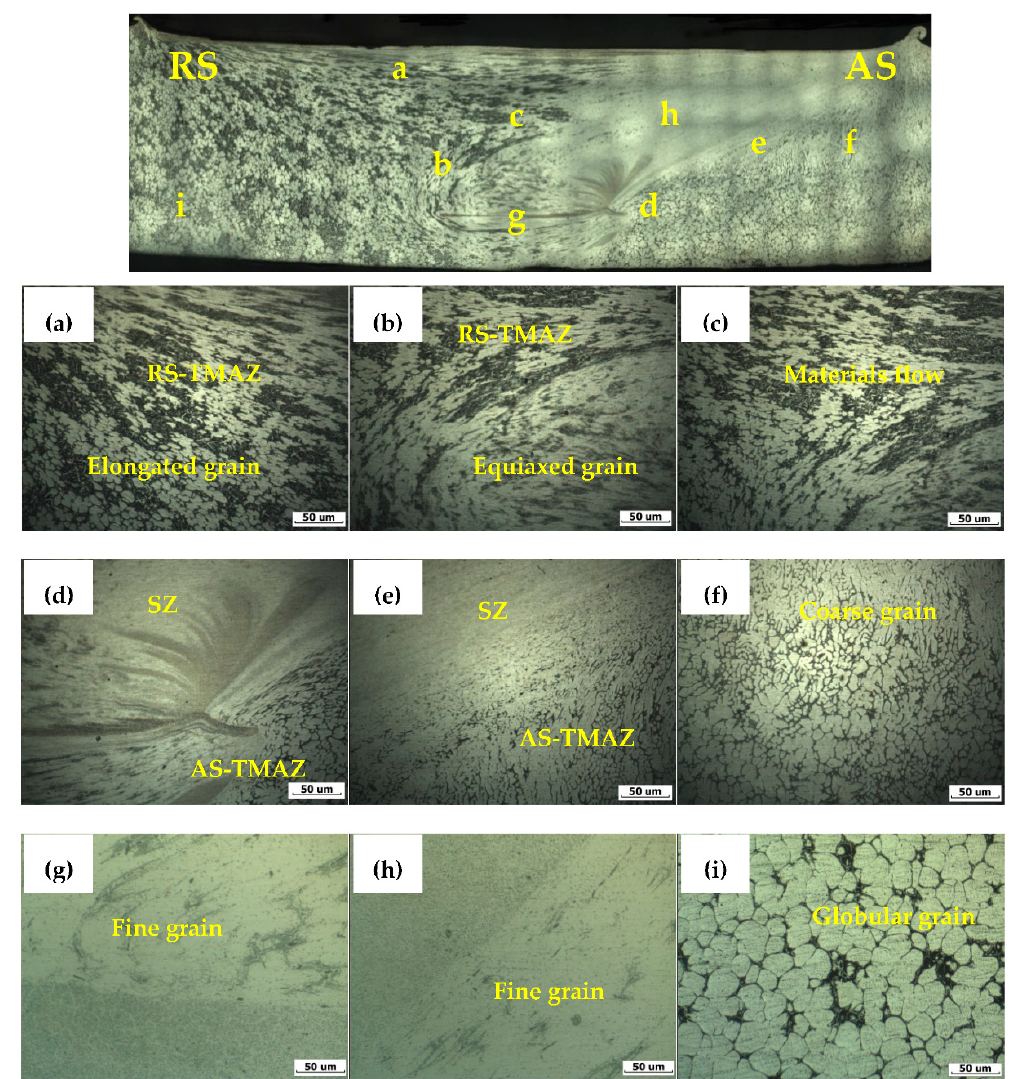
Figure 8. The photography of microstructure in the joint from rotation speed 1320 rpm, welding speed 60 mm/min, and cylindrical tool. ( a – i ) nine different types of microstructural changes were observed under microscope.